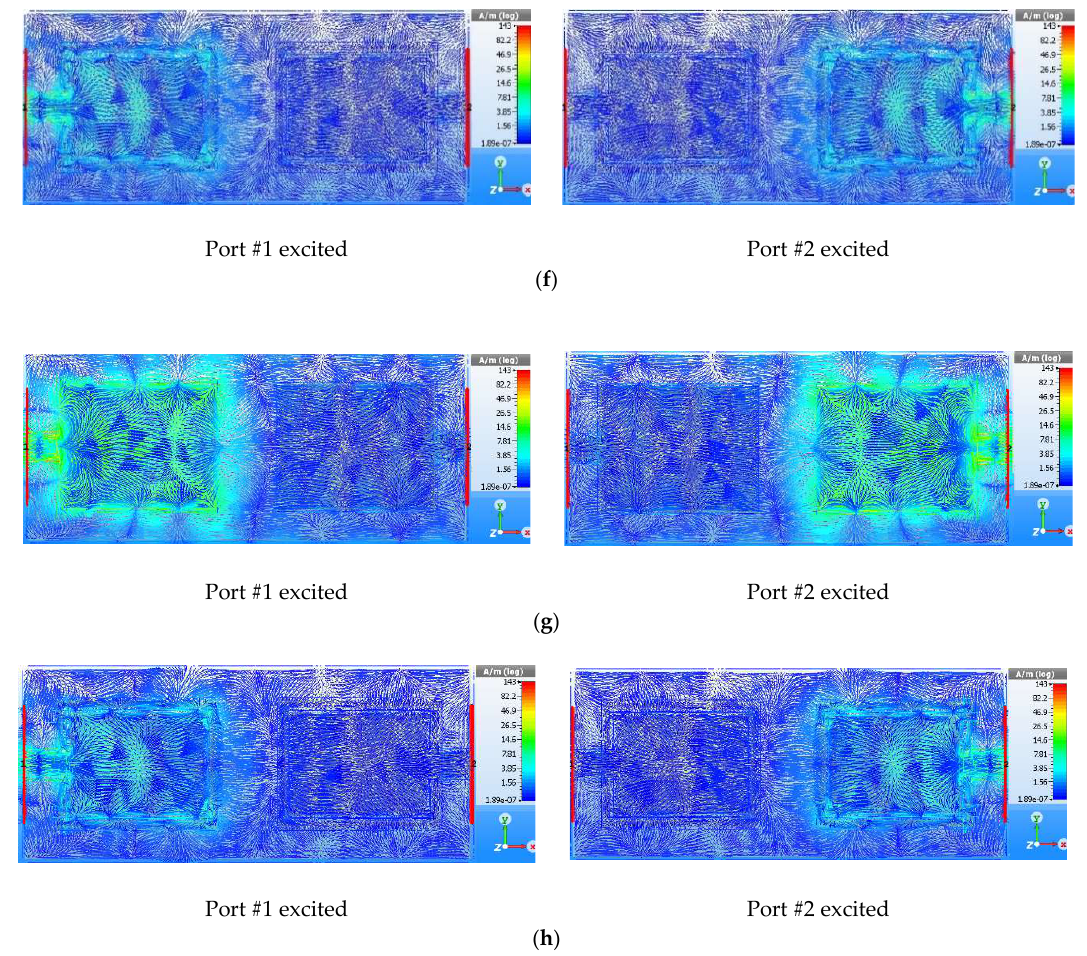
Figure 4. Surface current distribution over the reference and slotted arrays. ( a ) Reference Array@ 11.37 GHz in X-band; ( b ) Proposed Slotted Array@ 11.37 GHz in X-band; ( c ) Reference Array@ 13.6 GHz in Ku-band; ( d ) Proposed Slotted Array@ 13.6 GHz in Ku-band; ( e ) Reference Array@ 15.9 GHz in Ku-band; ( f ) Proposed Slotted Array@ 15.9 GHz in Ku-band; ( g ) Reference Array@ 18.7 GHz in K-band; ( h ) Proposed Slotted Array@ 18.7 GHz in K-band.